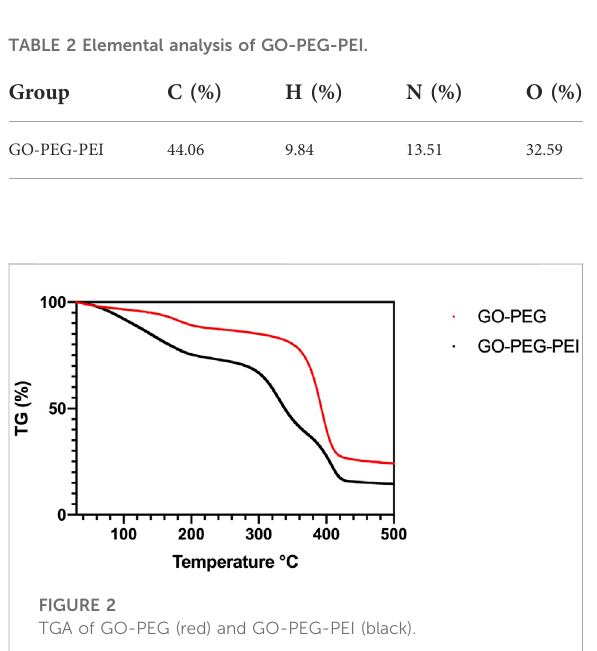
FIGURE 2 TGA of GO-PEG (red) and GO-PEG-PEI